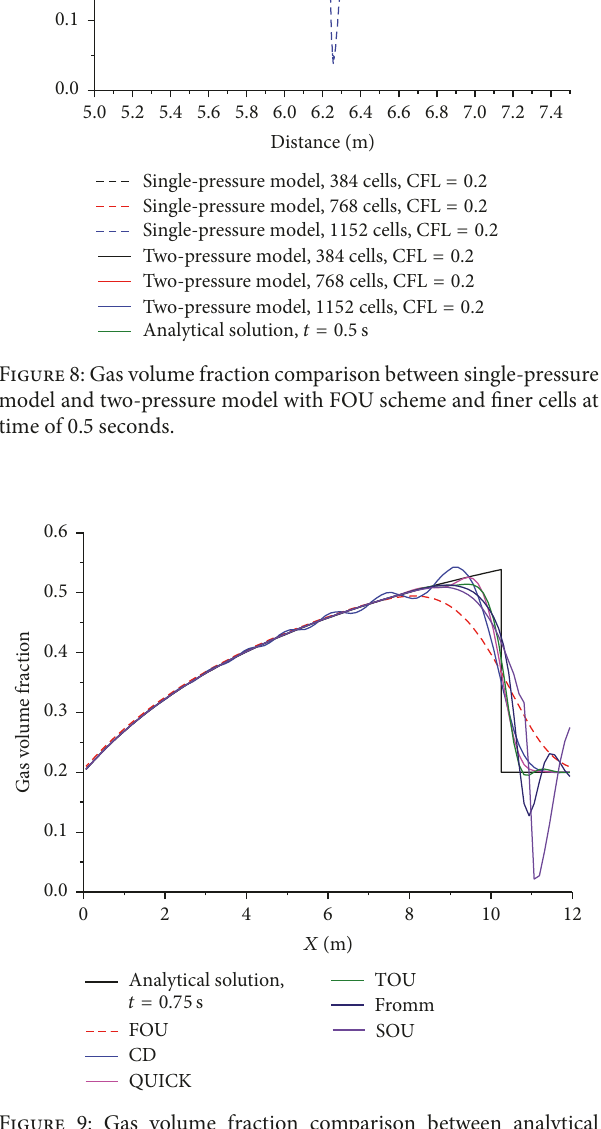
Figure 9: Gas volume fraction comparison between analytical solutions and numerical solutions using standard high-order linear schemes with 96 cells at time of 0.75